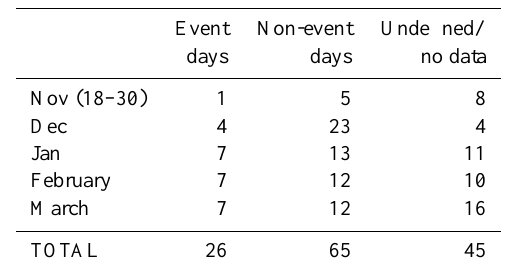
Fig. 4. Example of a typical particle formation event seen with both the AIS (b) and the DMPS (a) . Note the difference in color scale. Typical for particle formation events observed at the SORPES-NJU station is the gap visible in the AIS data, indicating that the neutral pathway dominates particle formation. Table 3. Event statistics.